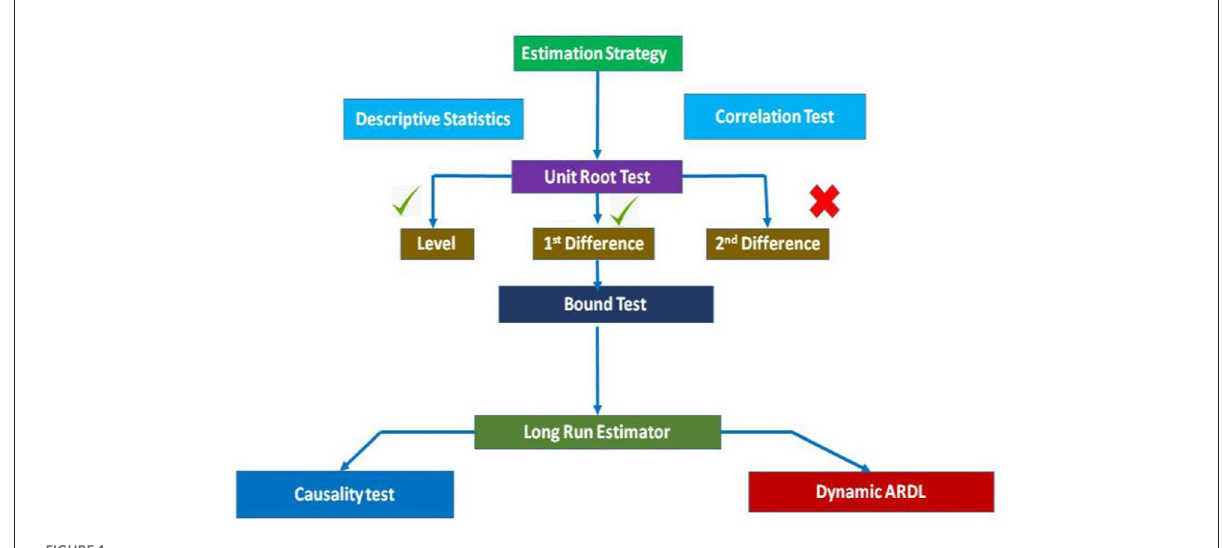
FIGURE1 Estimation strategy flow